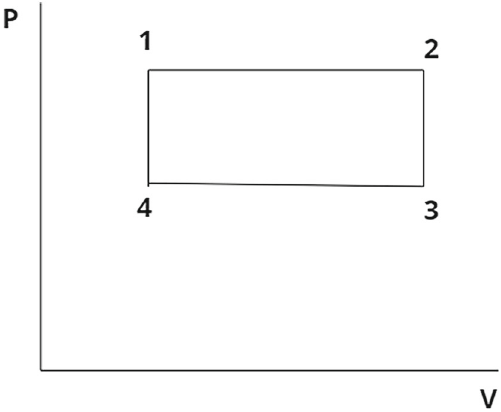
Fig. 4 A Carnot cycle for null C V